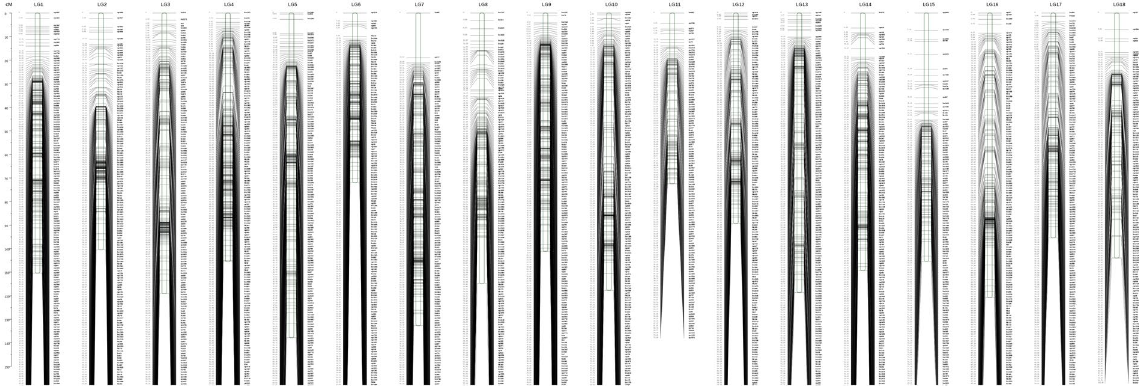
Figure 2. The high-density consensus linkage map of R. philippinarum . The consensus map which contained 9658 markers in 18 linkage groups was constructed through combing the male and female linkage maps.